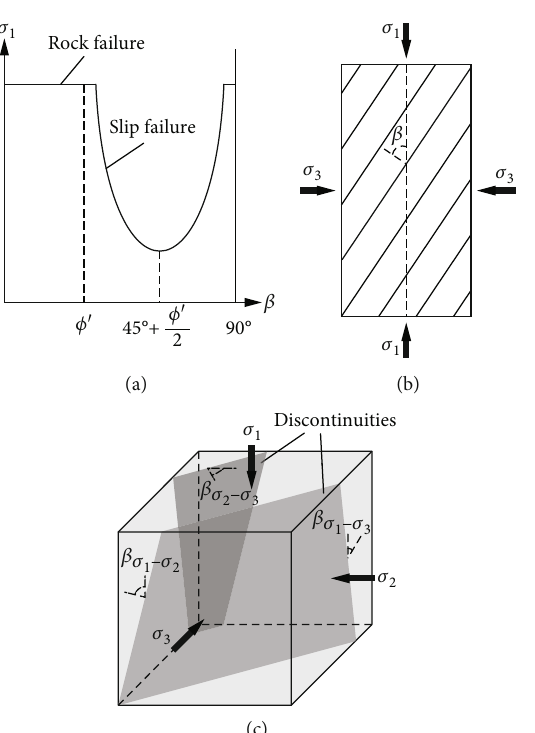
Figure 3: (a) Variation of the peak rock strength with β , at a constant con fi ning pressure. (b) Transversely isotropic specimen in triaxial compression. (c) 3D view of a specimen with inclined discontinuities in anisotropic stress